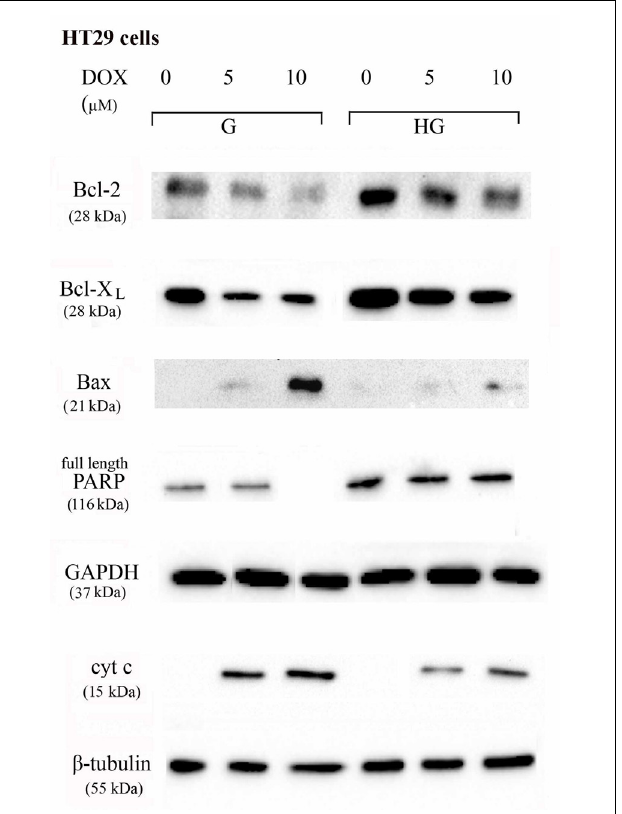
FIGURE 8 | Effect of normal glucose (G) and high glucose (HG) on Bcl-2, Bcl-XL, Bax, PARP and cyt c protein expression in absence or presence of DOX in human colon cancer HT29 cells. Cells were cultured for ≥ 7 days in the presence of G and HG, incubated for 24 h before analysis with 5 and 10 µ M DOX, then washed and lysed. The level of GAPDH, used as an housekeeping protein in total lysates, and the level of β -tubulin, used as an housekeeping protein in mitochondrial lysates, were used to check the equal protein loading. The figure is representative of three independent experiments.